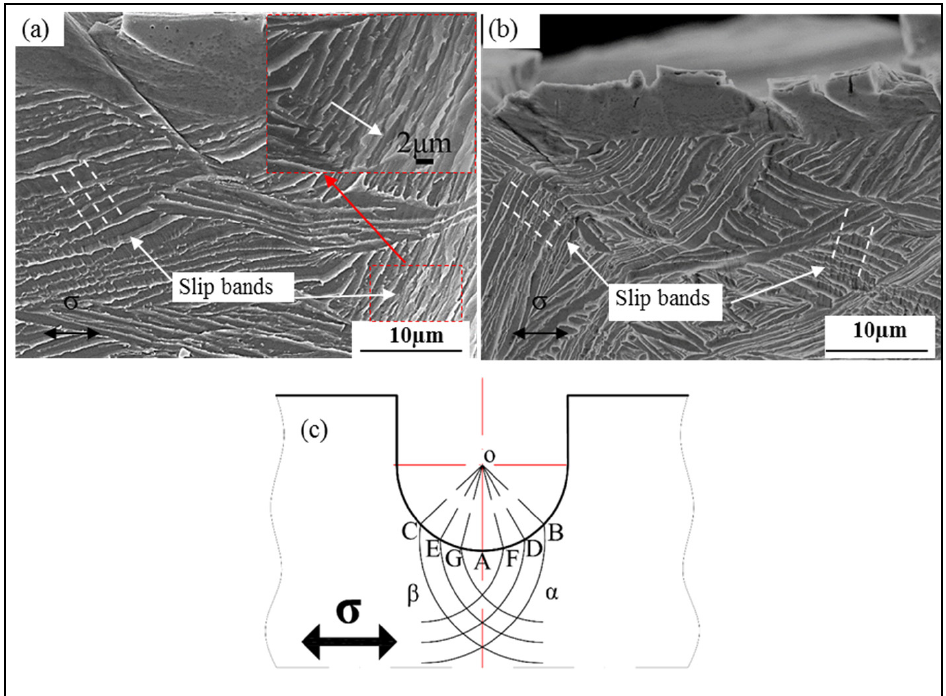
Figure 6. Slip band morphologies during crack initiation and schematic diagram of the slip line field of the circular-notched ( a ) FC and ( b ) OFC specimens. ( c ) The schematic diagram of the slip line field of FC and OFC specimens.